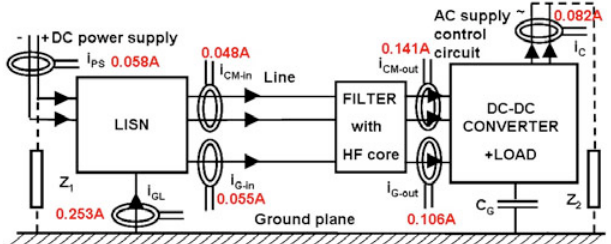
Figure 31: Maximum values of CM currents with CM and DM filter (plus HF ferrite core).